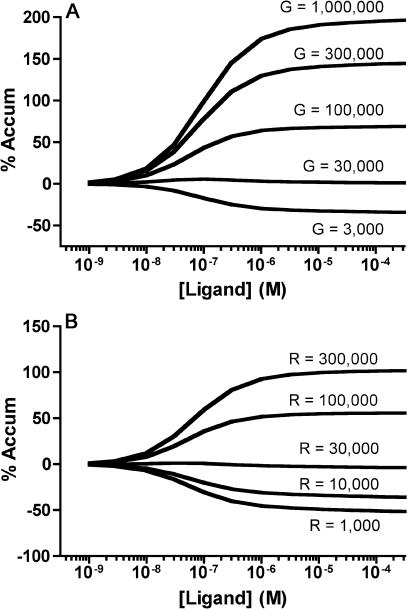
The Effect of Changing Receptor and G Protein Expression on the Activation of G ProteinDose response curves measuring the percent accumulation of GαGTP (%Accum) were calculated according to Equation 2 as described in Methods.(A) Total G protein (Gtotal) is varied from 1,000,000/cell to 3,000 per cell, and Rtotal = 5,000/cell.(B) Total receptor (Rtotal) is varied from 30,000 to 1,000 per cell, and Gtotal = 10,000/cell. Parameter values: k1 = 1 s−1, k3 = 1 × 107 M−1s−1, k11 =1 × 10−4 (number/cell)−1s−1, kGact = 5 s−1, kGTP = 1 s−1, kG = 1 × 10−4 (number/cell)−1s−1, Ka = 1 × 10−8 M−1, Kg = 1 × 10−4 (number/cell)−1, Kact = 0.01, α = 5, β = 5, δ = 0.5, γ = 0.1, η = 0.1.